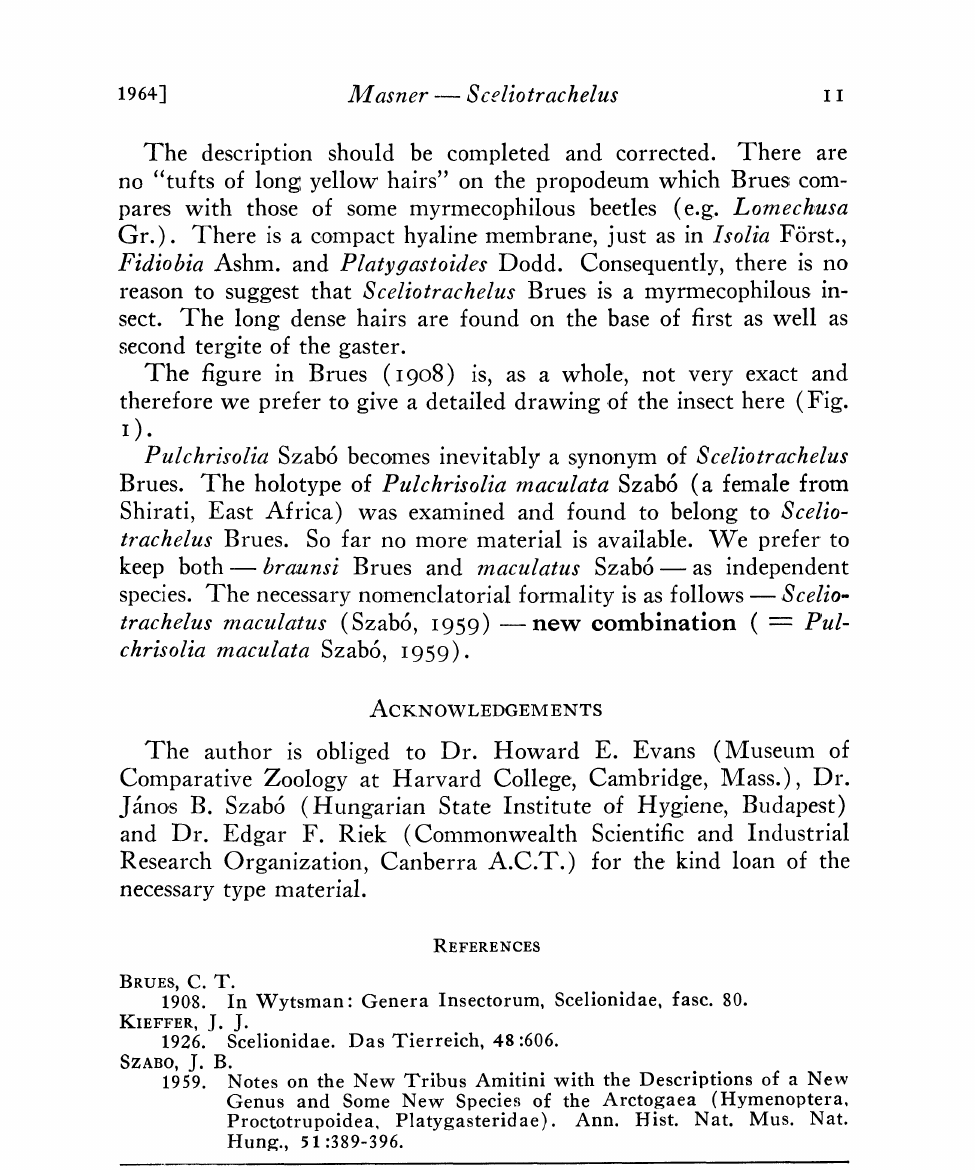
Fig. 4. Platygastoides mirabilis Do.dd, female,